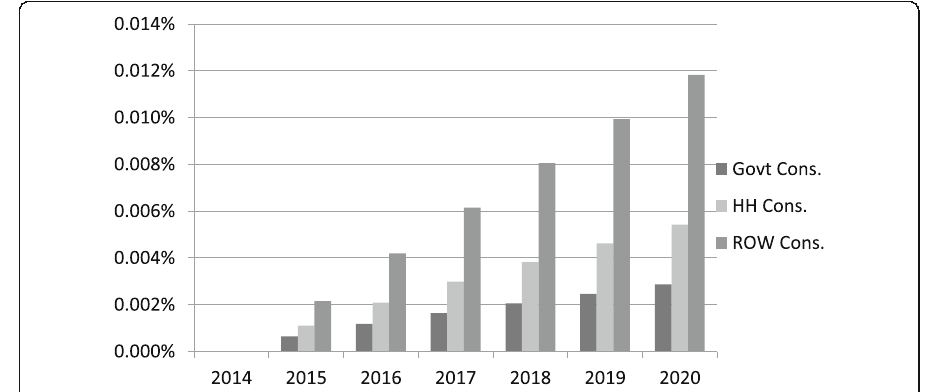
Fig. 2 Percentage change in consumption of institutional sectors from the benchmark